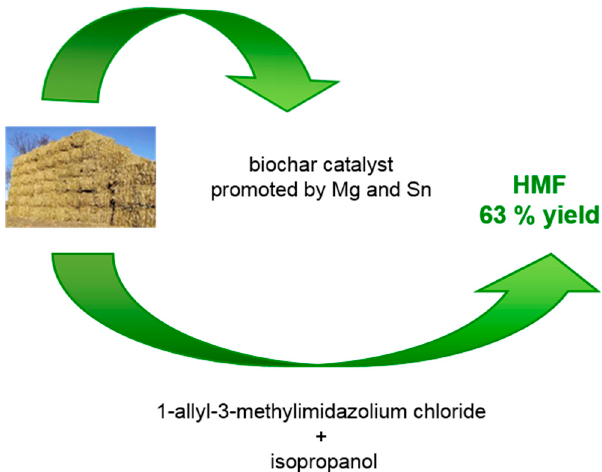
Figure 9. Schemes of the process from corn stalks to be used both for the synthesis of the catalyst and as raw biomass to be transformed into HMF [46].